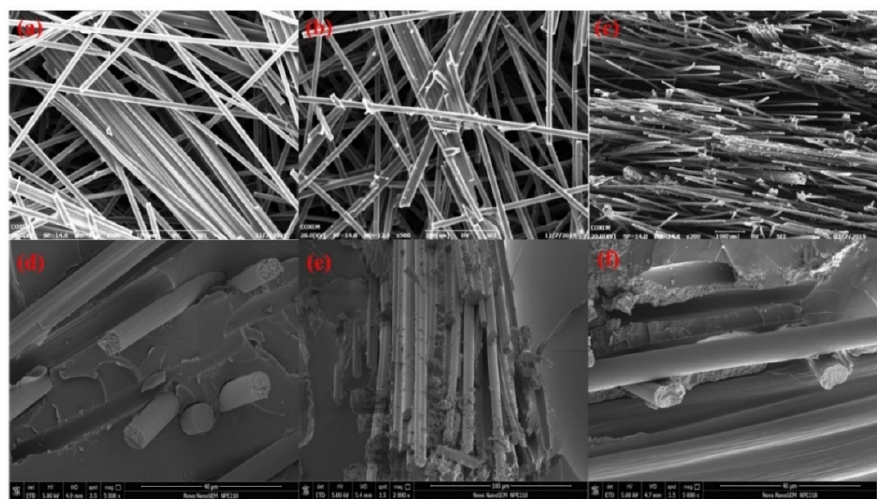
Figure 5. ( a ) The morphology of the CF felt in the in-plane direction, ( b ) the CF/C felt in the in-plane direction, ( c ) in the through-plane direction, ( d – f ) the CF/C/EP composite.